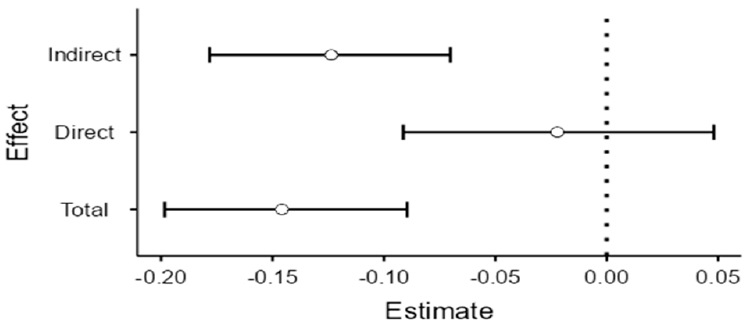
Figure 2. The mediation effect of resilience between SEL and internalizing problems: estimate plot.